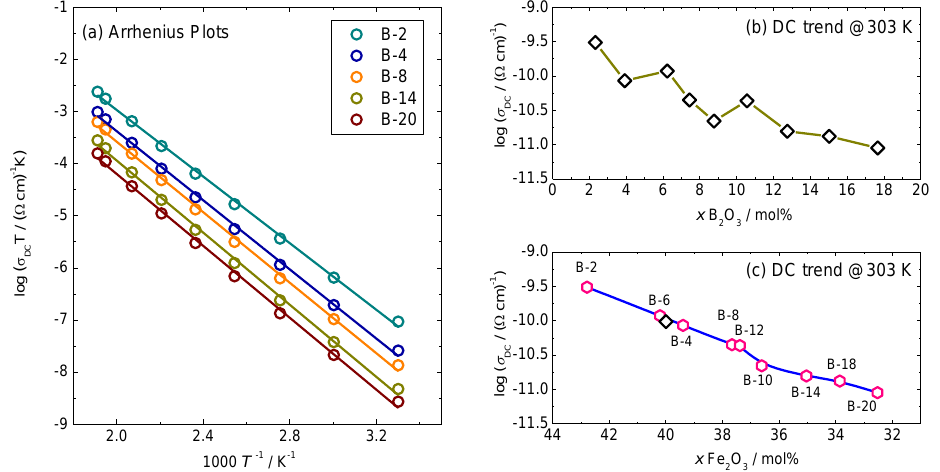
Figure 2. ( a ). Temperature dependence of DC conductivity (log( σ DC T ) vs. 1 / T) for selected glasses from x B 2 O 3 –(100 − x )[40Fe 2 O 3 –60P 2 O 5 ] series and ( b , c ) DC-conductivity at 303 K as a function of B 2 O 3 and Fe 2 O 3 content, respectively, for glasses from x B 2 O 3 –(100 − x )[40Fe 2 O 3 –60P 2 O 5 ] series. Solid lines in ( a ) represent the least-square linear fits to experimental data, whereas lines in ( b , c ) are drawn as guides for the eye. Black open diamond symbol in ( c ) is the experimental data for 40Fe 2 O 3 -60P 2 O 5 glass reported in [30].